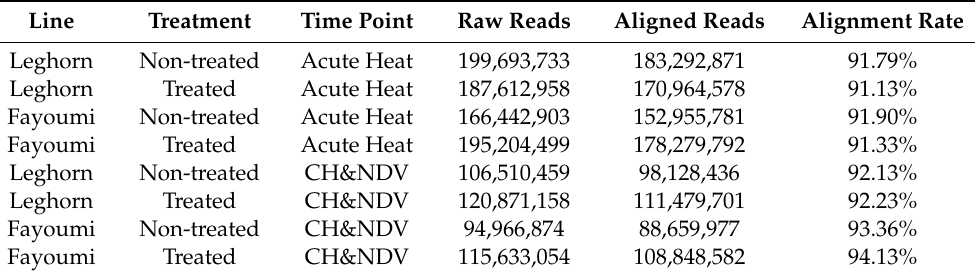
Table 1. Summary statistics of the RNA-seq data.